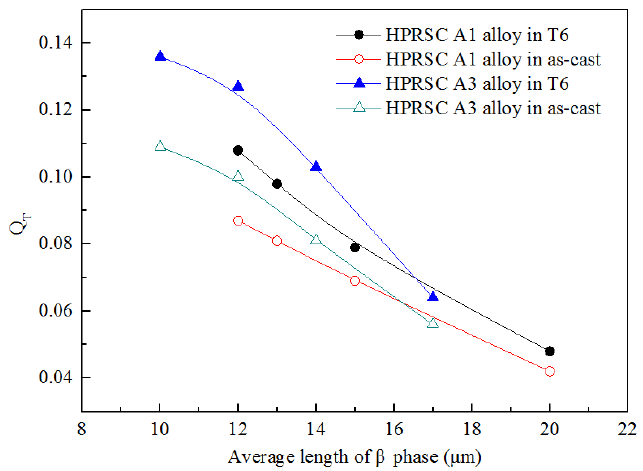
Figure 17. Plot of yield strength (YS) versus elongation of HPRSC A1 and A3 alloys.